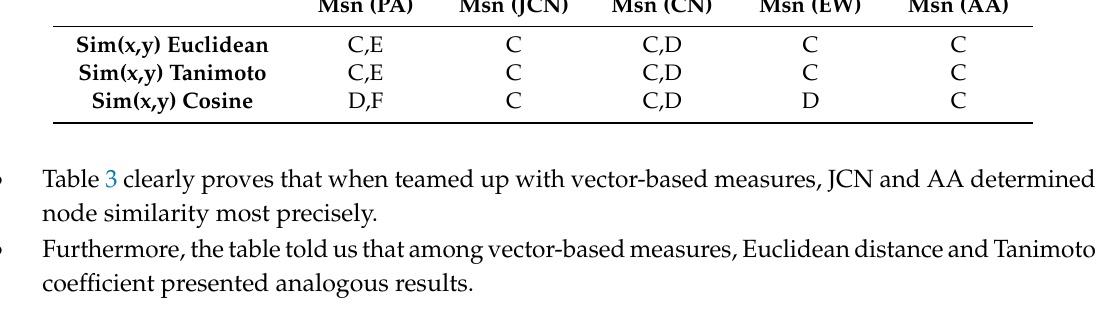
Table 4. Pearson’s coefficient for neighbor-based metrics.